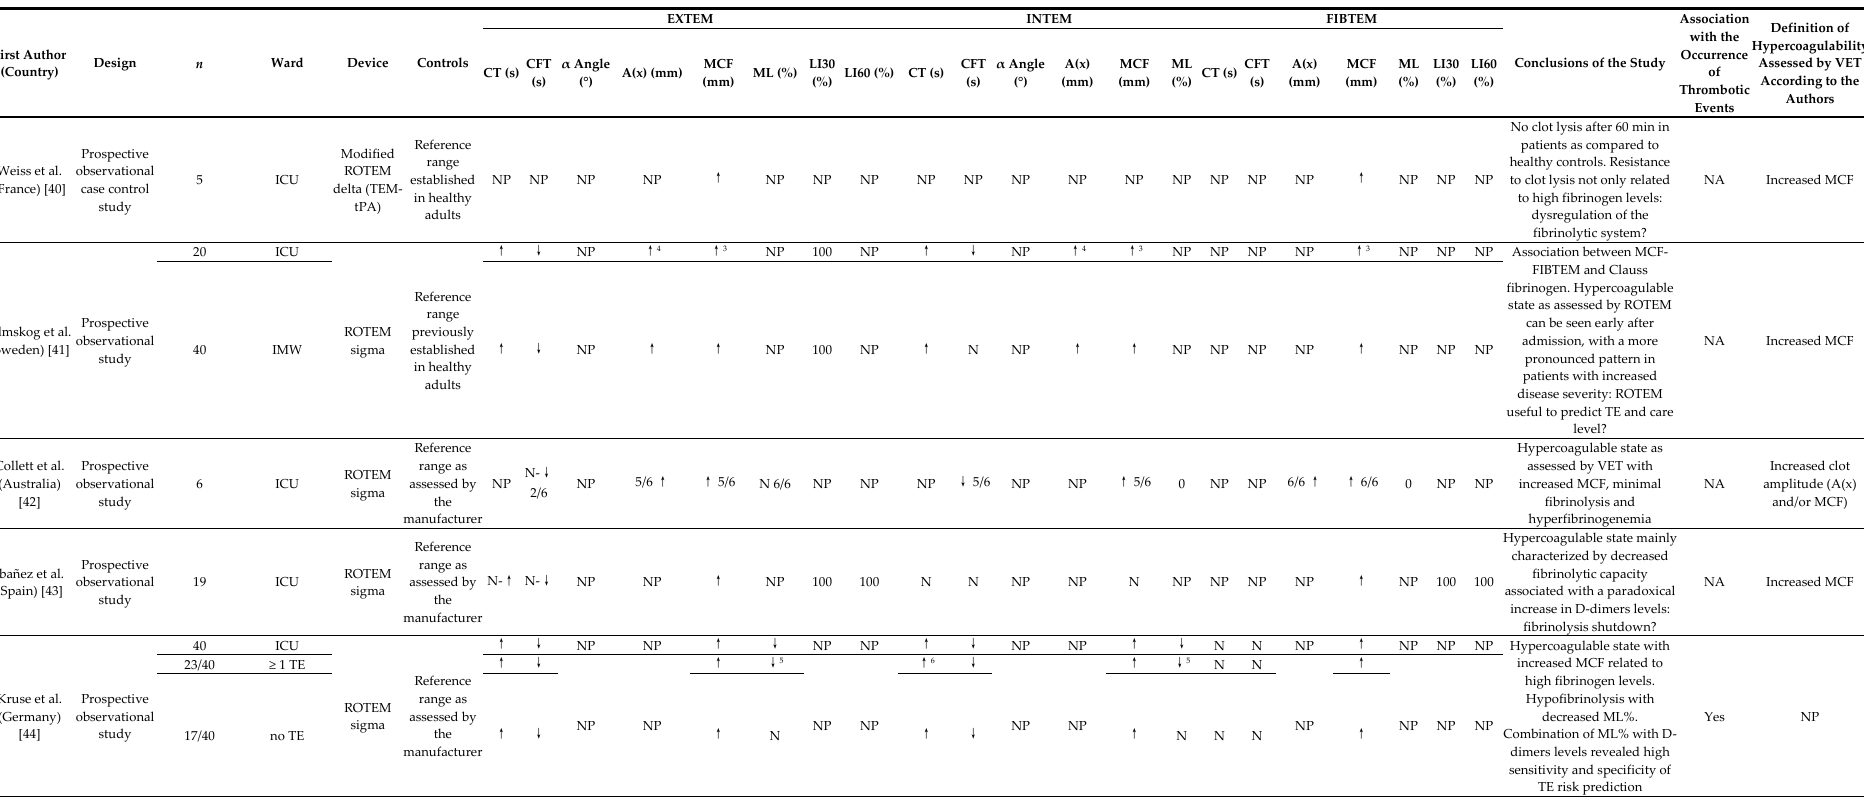
Table 5. Main findings of studies reporting ROTEM results (except APTEM and TEM-tPA